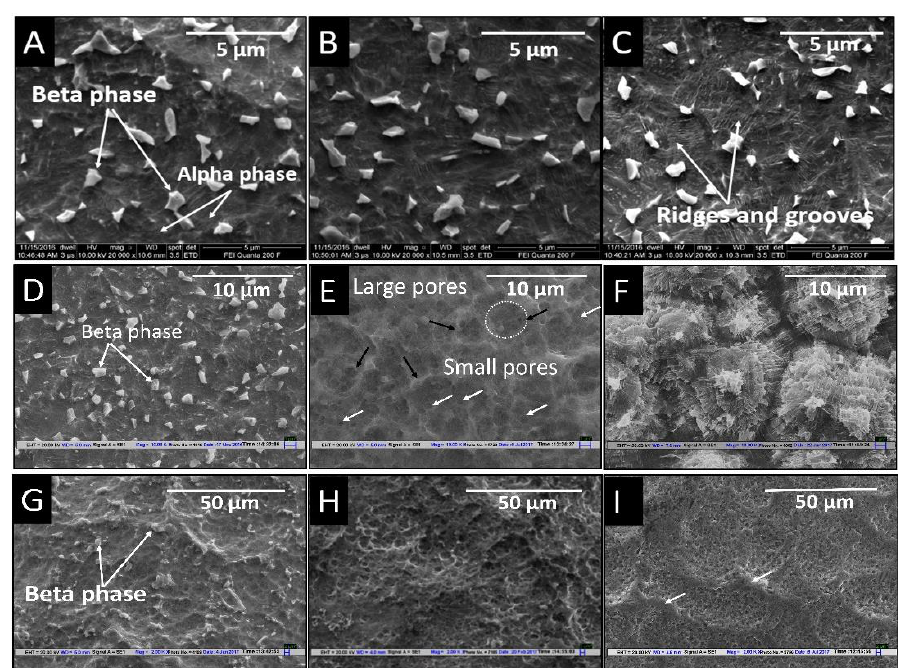
Figure 4. SEM images of sandblasted dental implant acid-etched with HF for 30 s (RT) and second etching with HCl + H 2 SO 4 at room temperature ( A – C ) for a duration of ( A ) 1 min, ( B ) 5 min, ( C ) 10 min; ( D – F ) second etching with HCl + H 2 SO 4 for a duration 3 min at ( D ) 40 °C, ( E ) 80 °C, and ( F )120 °C; and ( G – I ) second etching with HCl + H 2 SO 4 at HT for the duration ( G ) 1 min ( H ) 5 min; and ( I